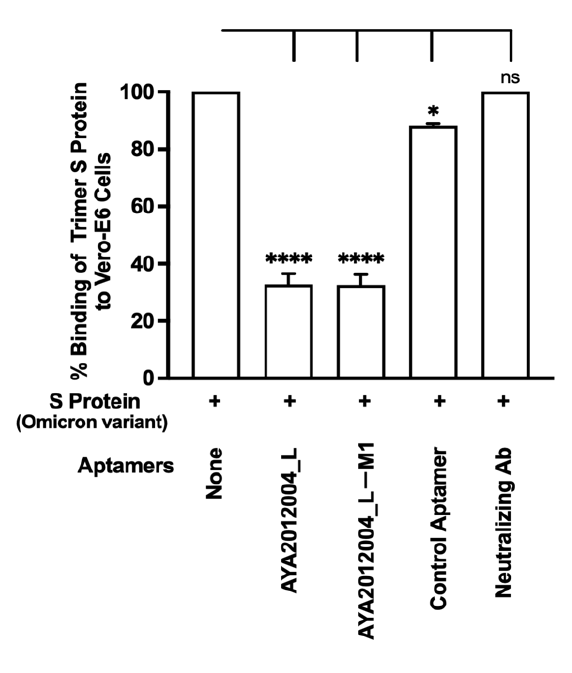
Figure 9. Inhibition binding of Omicron SARS-CoV-2 trimer S protein to ACE2 receptors on the surface of Vero E6 cells by selected aptamers. His-tagged Omicron SARS-CoV-2 trimer S protein was incubated with Vero E6 cells in the absence or presence of the indicated aptamers or anti-SARS-CoV-2 RBD neutralizing Ab at 30 nM. After 1 h incubation, unbound S protein was washed out, and the cell pellet was solubilized with 1% Triton X100 for 1 h. Supernatant containing solubilized S protein was applied to the nickel-coated plate. The His-tagged trimer S protein bound to nickel was detected using mouse monoclonal antibodies against S protein and horseradish peroxidase-conjugated goat anti-mouse antibodies. Each value was the average of duplicate measurements. Error bars represent mean ± SD ( σ ). p -values were determined with one-way ANOVA, Dunnett’s multiple comparison test. * denotes p < 0.015 and **** denotes p <